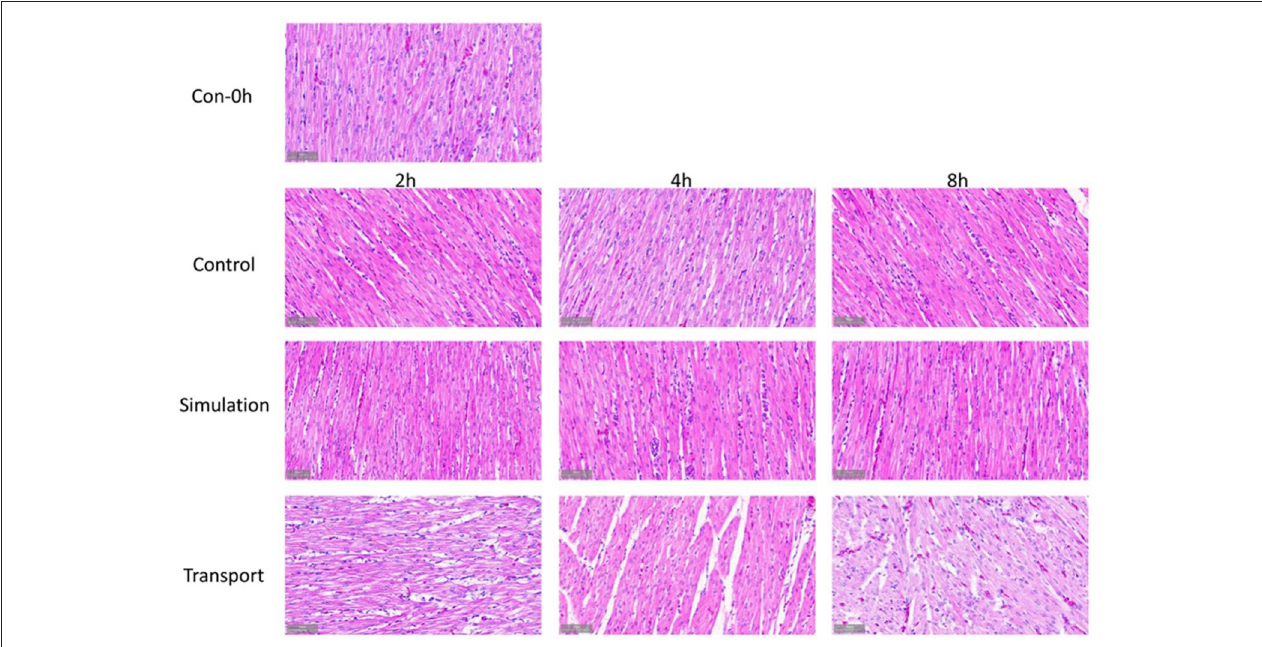
FIGURE 2 | Comparison of macroscopic view from the chick heart in groups (400 × H&E staining).